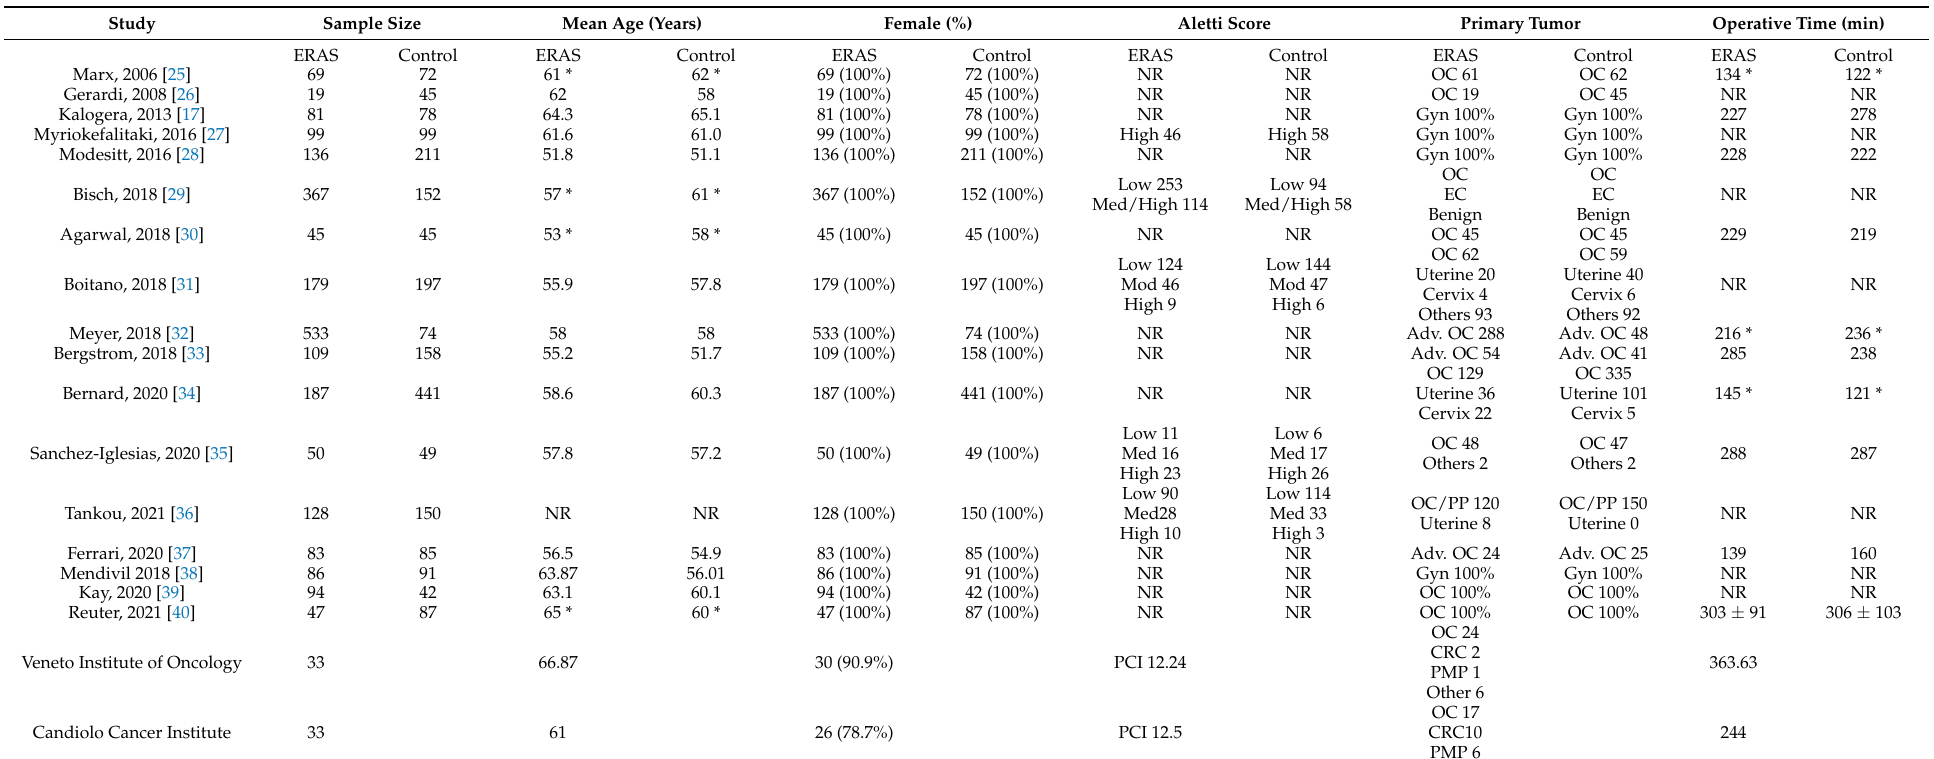
Table 2. Details of included studies about